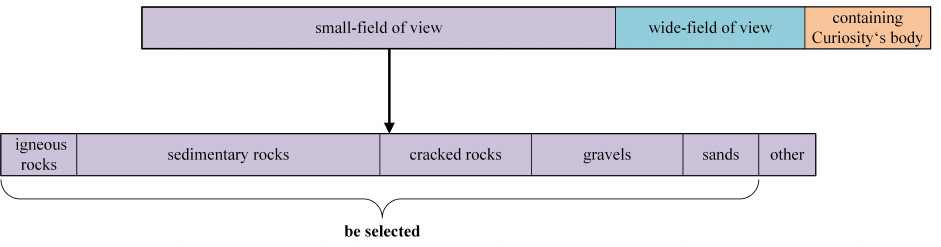
Figure 5. Composition of mars32k. Mars32k contains 32,368 images, including 19,867 images with small-field, 7950 images with wide-field and 4731 images with Curiosity‘s body. The small-field images include 1530 igneous rock images, 5954 sedimentary rock images, 2718 cracked rock images, 2947 gravel images, 1720 sands images and 4998 unclassified